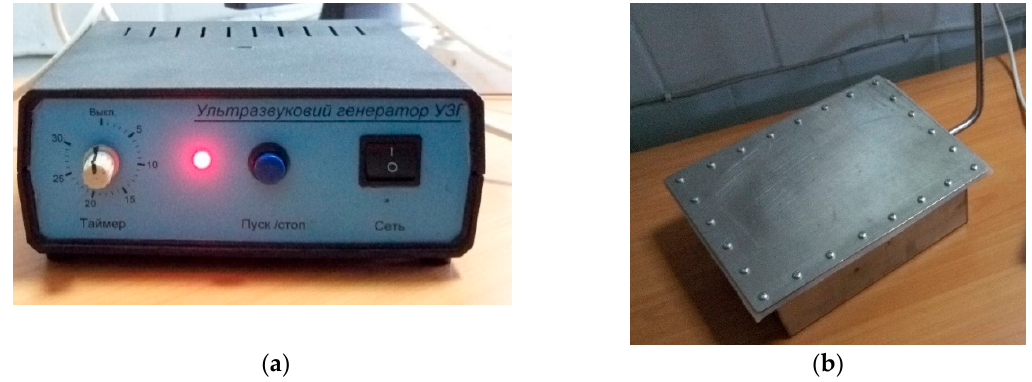
Figure 6. Laboratory studies of the effect of forced disturbed displacement of a submarine model under the influence of acoustic shock( a ) ultrasonic transducer UZP-6-1; ( b ) ultrasonic